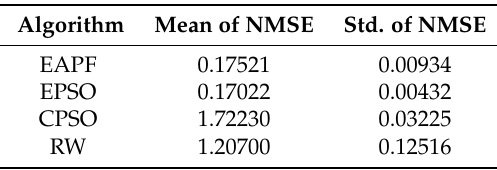
Table 2. Statistical results of the NMSE between the estimated GDMs and the actual GDMs at the final time step in the indoor